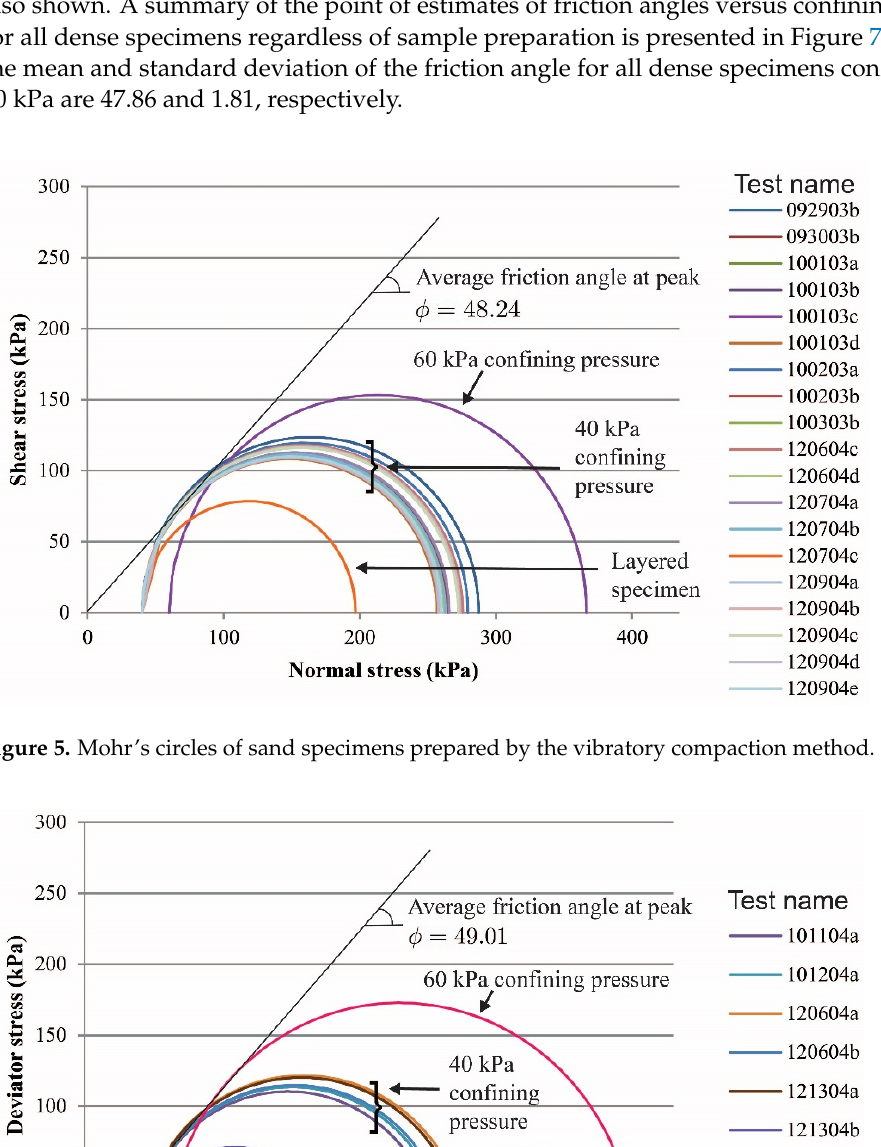
Figure 4. Global stress ‐ strain relations of sand specimens prepared by the dry pluviation method.